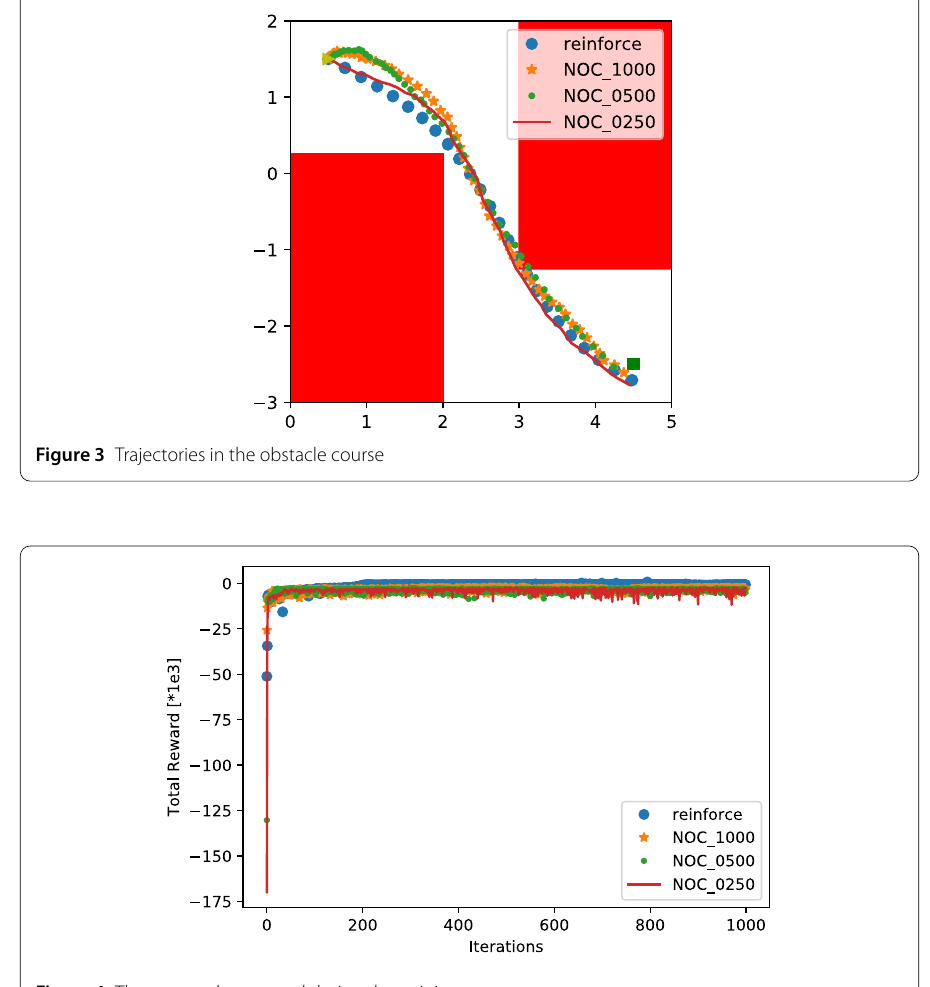
Figure 4 The summed up reward during the